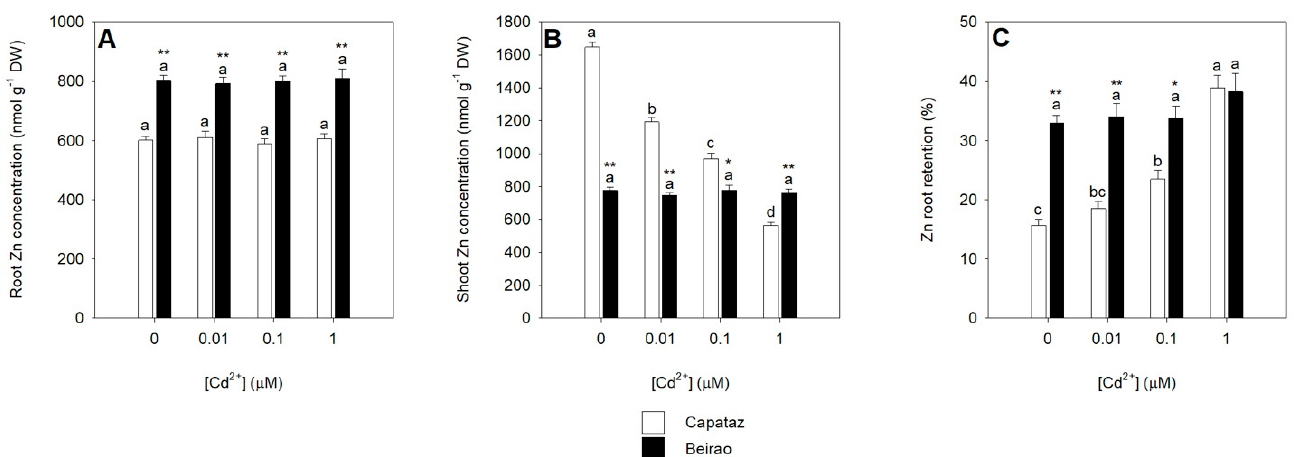
Figure 4. Effects of Cd on Zn partitioning between roots and shoots. Capataz (white bars) and Beirao (black bars) were exposed to different Cd concentrations (0.01, 0.1, and 1 μ M) for 10 days. Zn concentration in roots ( A ) and shoots ( B ). Zn root retention ( C ). Bars and error bars are means and SE of two experiments run in triplicate (n = 6). Different letters indicate significant differences among treatments ( p < 0.05). Asterisks indicate significant differences between Capataz and Beirao (Student’s t -test; * 0.001 ≤ p < 0.005; ** p < 0.001). DW, dry weight.